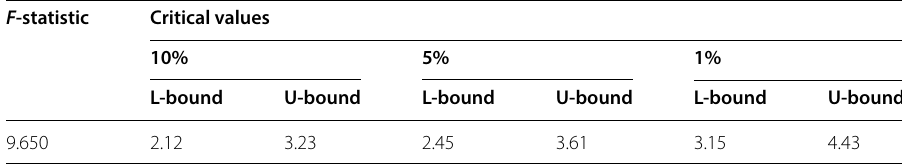
Table 3 Results of bounds test using F -statistic (U computation from World Development Indicators database for